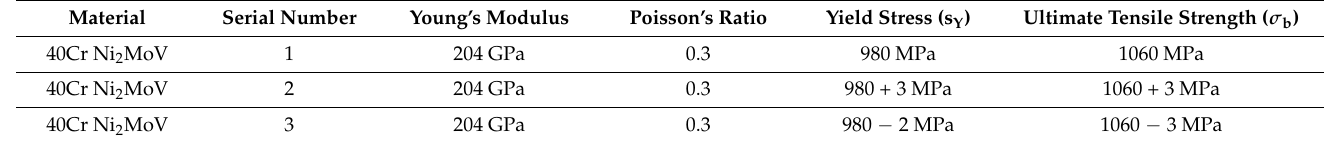
Table 3. Static mechanical properties of nickel-chromium alloy.